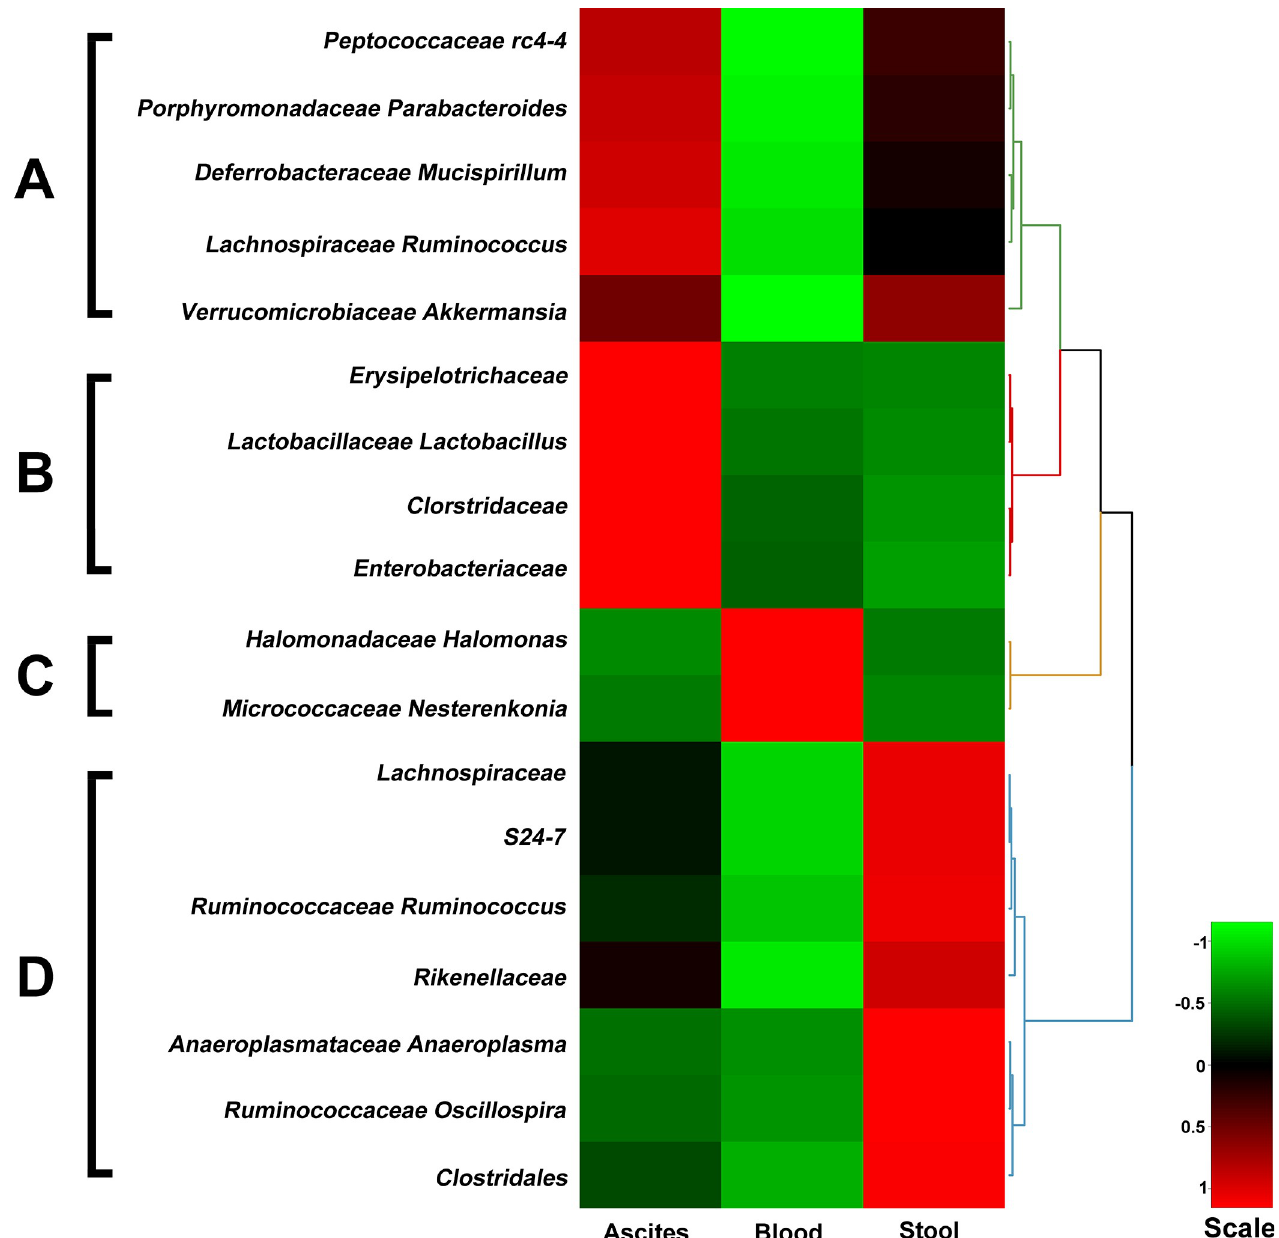
Fig 1. The microbiota composition of phyla in the samples of ascites, blood, and stool of the sham-operated C57BL/6 mice (0 h) and of the C57BL/6 mice receiving CLP for 4 h, 8 h, and 16 h.